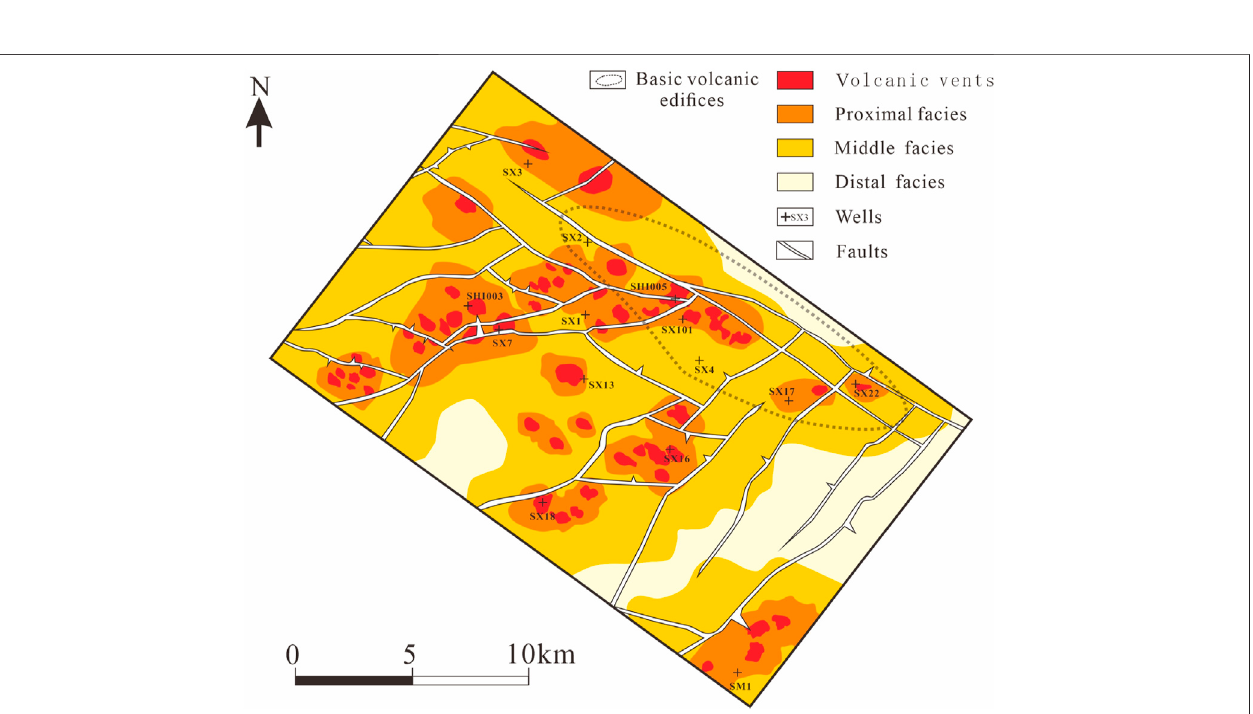
Frontiers in Earth Science |